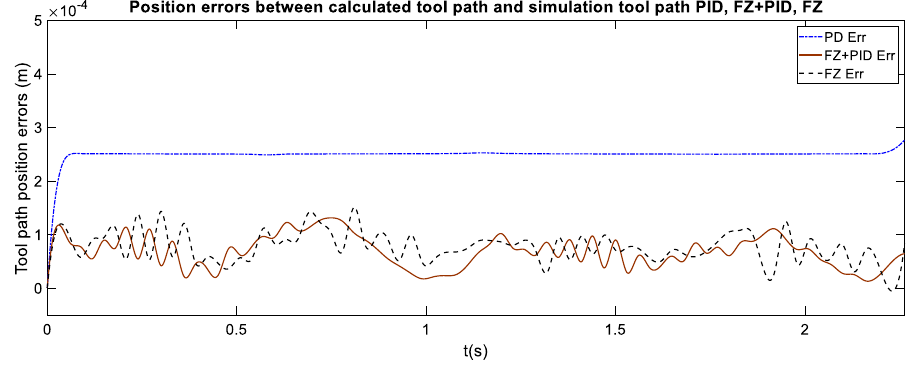
Figure 20. Tool path position errors between desired value and simulation result in cutting force mode increases by 50% due to noise. The result shows that the accuracies of Fuzzy and Fuzzy + PID controllers are almost the same. On the other hand, with noise increasing the external load (cutting force) within 50%, the accuracy is still guaranteed and the errors are negligible. Figures 19 and 20 also show the simulation results of the Inverse Dynamics + PD controller (no perturbation, Figure 19), and Inverse Dynamics + PID (with perturbation, Figure 20). The adjustment capability of the Inverse Dynamics + PID controller is found to be slower. Thus, among many methods of ensuring the stability and accuracy of the fuzzy controller, it is possible to say: -